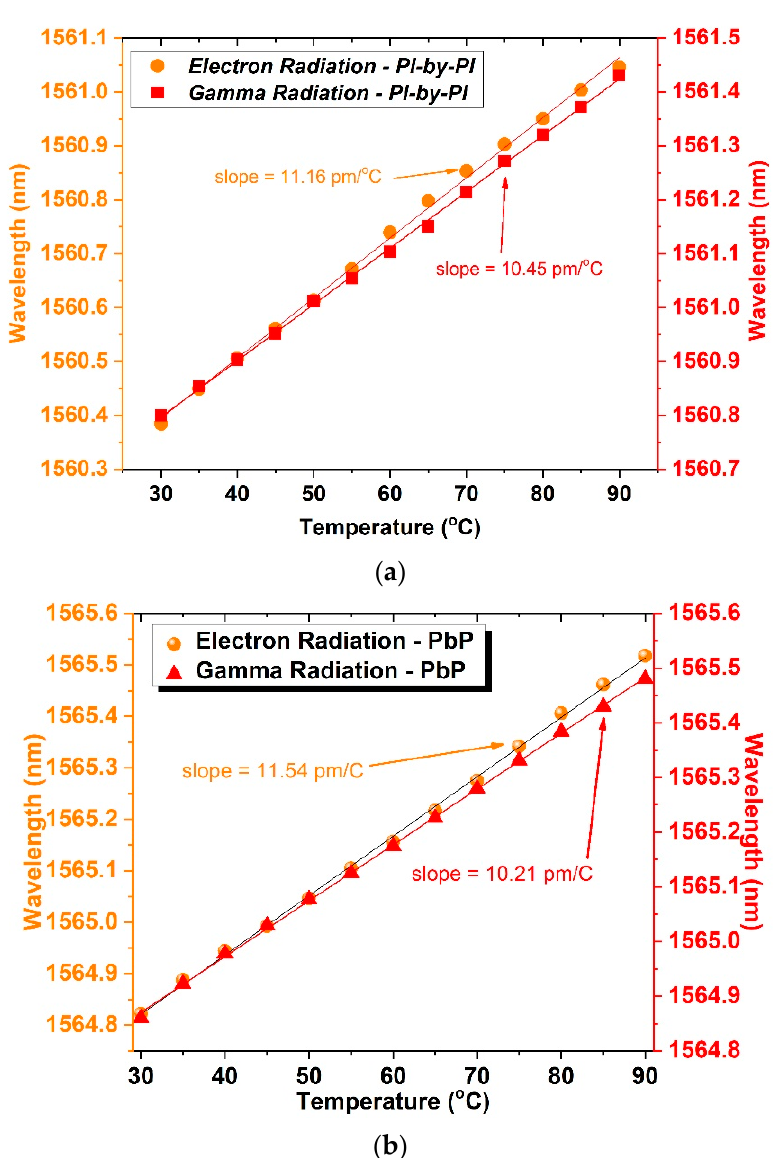
Figure 7. Temperature sensitivity of the FBGs after exposure to electron and gamma radiation, ( a ) PlbPl -inscribed FBG and ( b ) PbP -inscribed FBG.